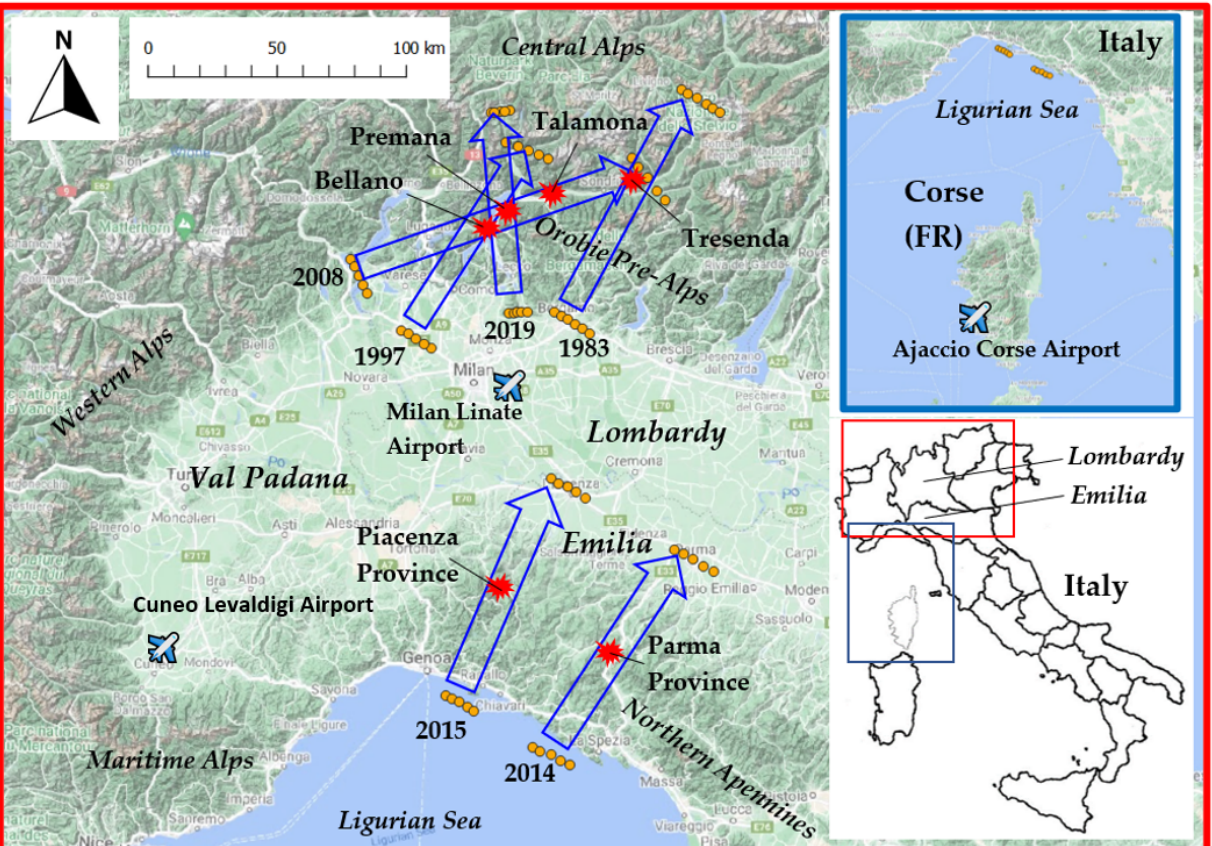
Figure 2. Case studies area over northern Lombardy (Central Alps) and Emilia (northern Apen- nines). Radiosondes of Milan Linate Airport, Ajaccio Corse Airport, and Cuneo Levaldigi Airport are considered for the initial conditions of LUME. The blue arrows show the traces considered for LUME computations, while the orange dots show the starting/ending points of each trace consid- ered for sampling the digital elevation model (DEM).